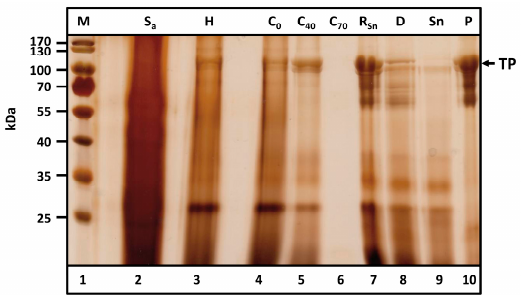
Figure 6. Pilot scale purification of Q-MaSp1-100× ELP from Nicotiana tabacum leaves. Samples of